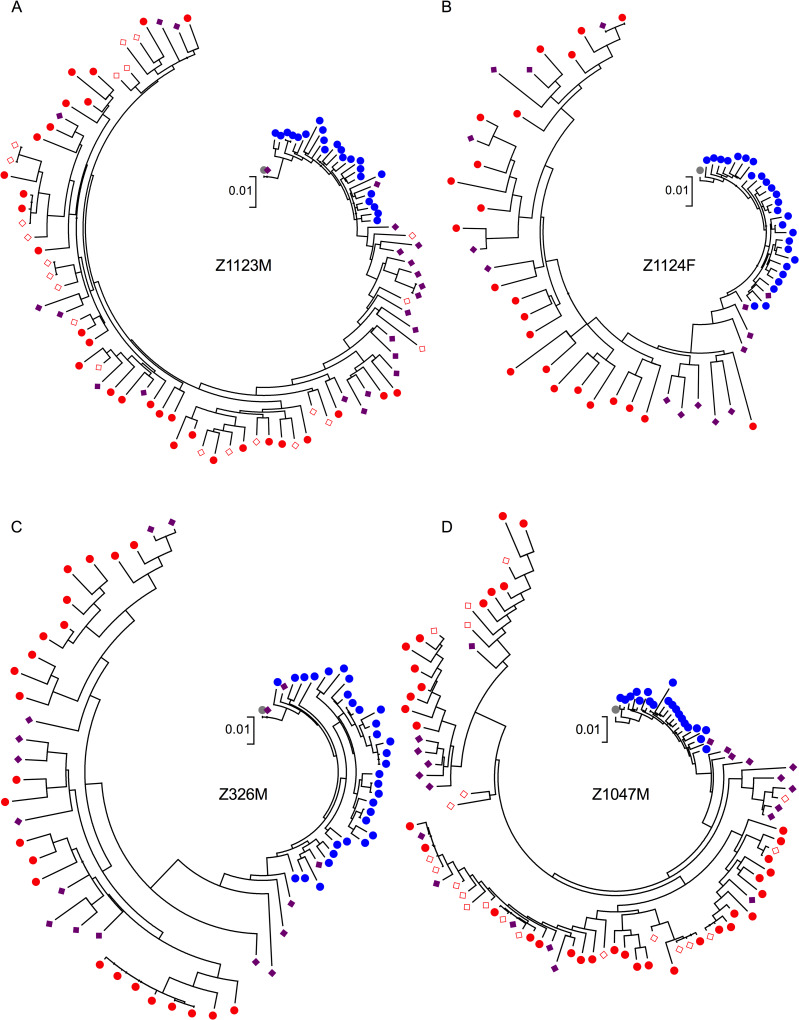
Maximum-likelihood (ML) trees for viral and proviral variants in four individuals.Representative ML phylogenetic trees for participants Z1123M (A), Z1124F (B), Z326M (C), and Z1047M (D) rooted on the respective transmitted/founder (TF) virus (grey) identified from the seroconversion sample and depicting all viral variants from one year post-infection (blue), the last ART-naïve sample (red), and during treatment (purple diamonds). Variants from cells collected at the last ART-naïve time point are shown in open red diamonds, while all plasma variants are in filled circles.